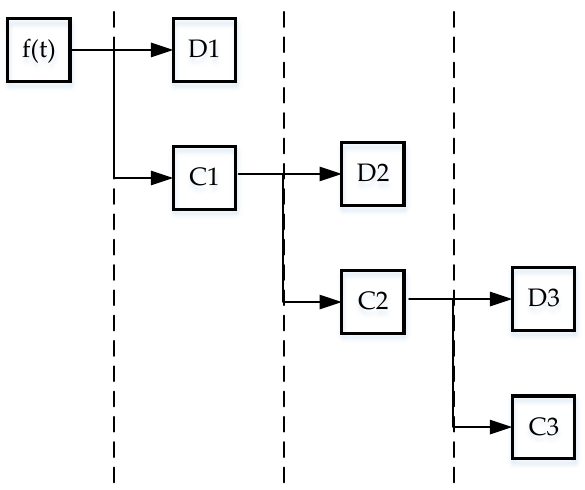
Figure 3. Decomposition of discrete wavelet.